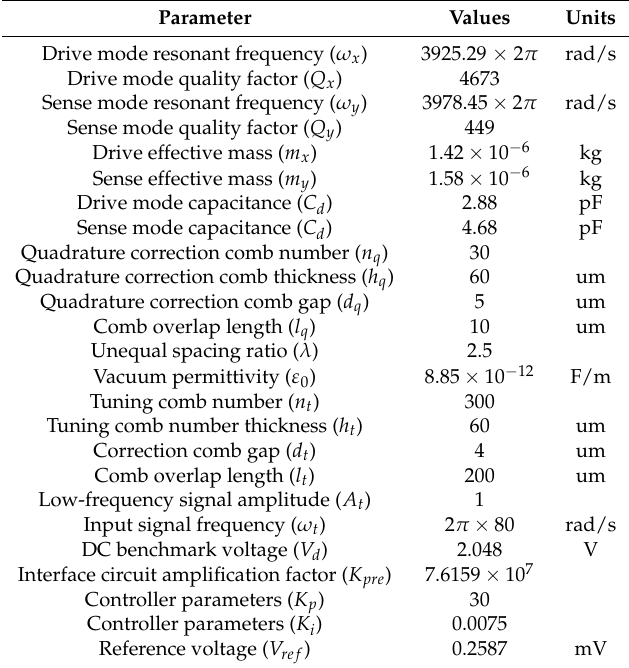
Table 1. Simulation parameters of the dual-mass MEMS